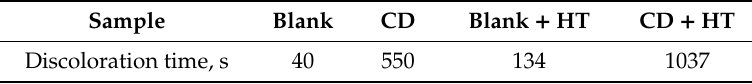
Table 2. Discoloration time of corrosive droplets on typical samples.